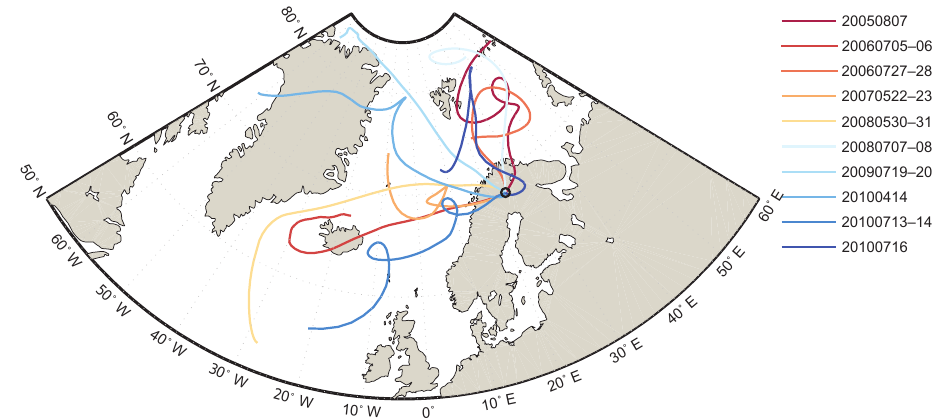
Figure 1. Mean HYSPLIT trajectories of each new particle formation event, all ending at Pallas. The trajectories start 7 days backward in time before they reach the measurement